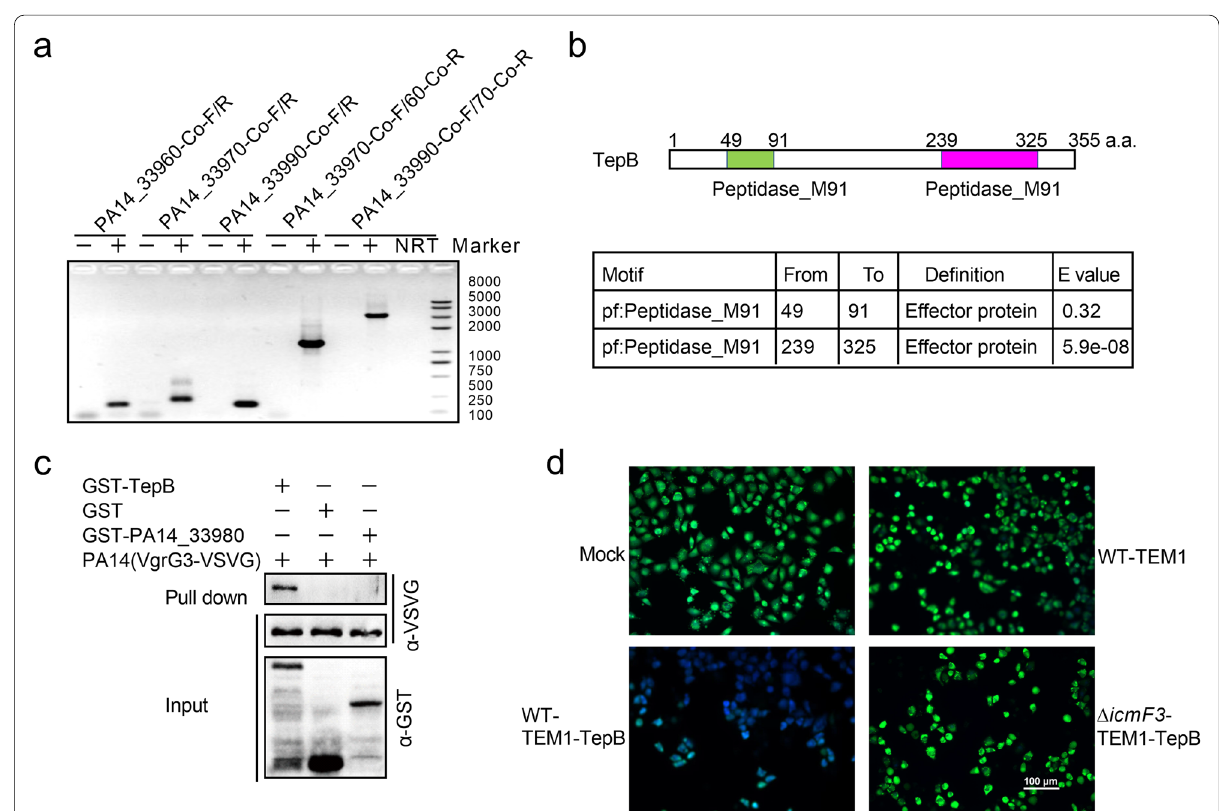
Fig. 2 TepB (PA14_33970) is a substrate of H3-T6SS. a Cotranscription analysis of PA14_33970–90 in P. aeruginosa PA14 by RT-PCR. -: PCR product with dd H 2 O as template. : PCR product with P. aeruginosa PA14 cDNA as template. NRT: PCR product with no reverse transcriptase sample of P. + aeruginosa PA14 RNA. b Protein motif prediction of TepB. c GST pull-down assay to detect the interaction between TepB and VgrG3. VgrG3-VSVG was incubated with GST, GST-TepB or GST-PA14_33980, and the protein complexes captured with glutathione beads were detected by Western blotting. d Translocation of TepB proteins into HeLa cells. HeLa cells were mock-infected or infected with indicated PA14 strains expressing TEM1-TepB at an MOI of 100 for 3 h and loaded with CCF2-AM. Visualization of the translocation of TepB using fluorescence microscopy. Scale bar, 100